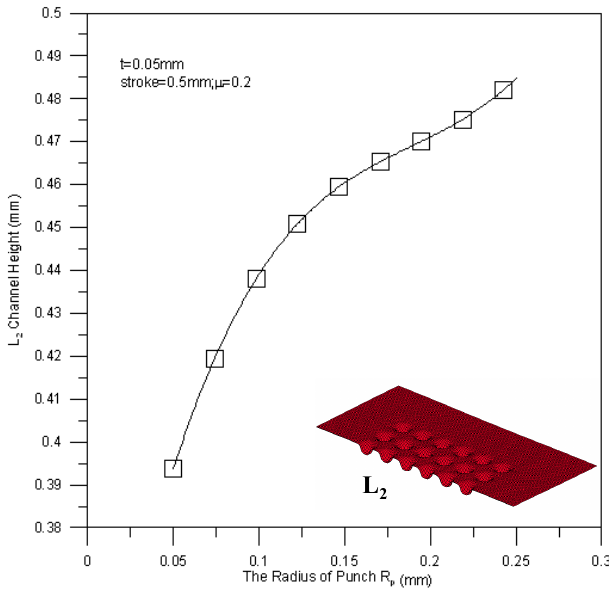
Figure 19. The relationship between the tool radius and the channel height of the L 2 section.